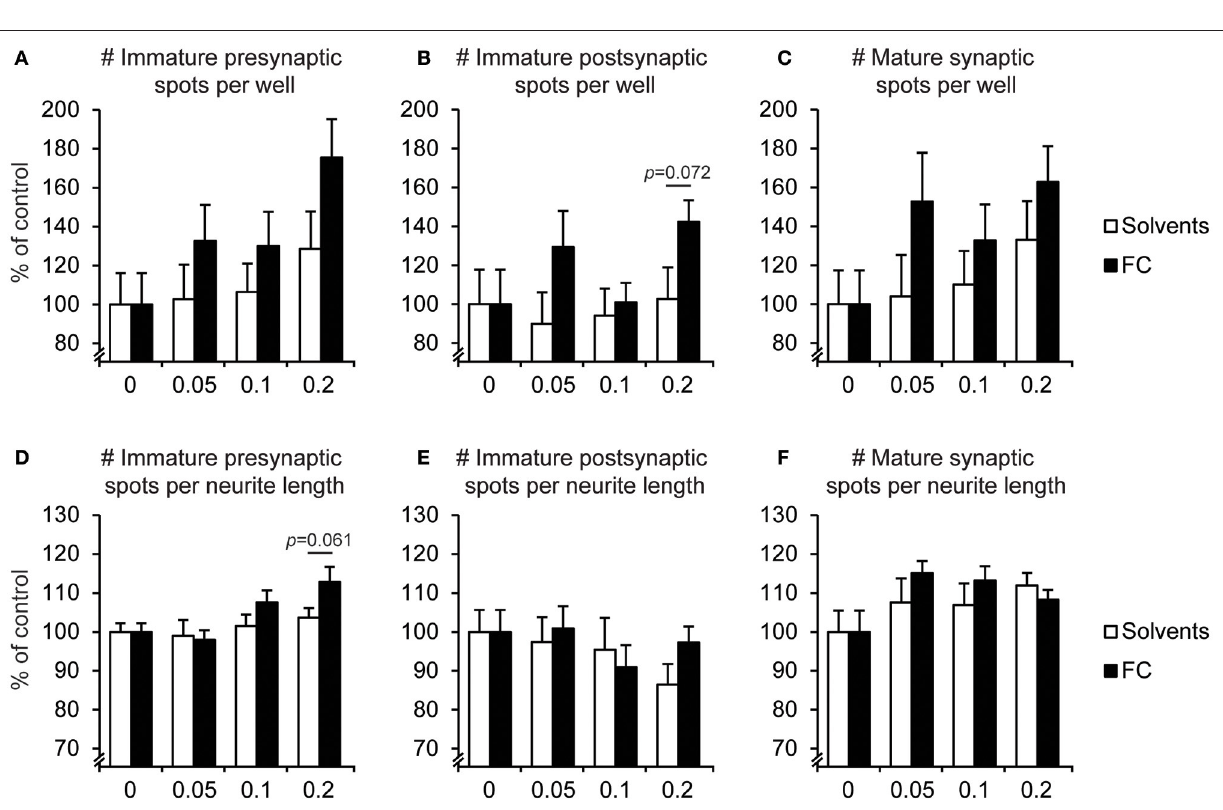
FIGURE 6 | Effect of FC on synaptic spots in primary neuron-astrocyte co-cultures . Analysis of number of (A,D) immature presynaptic spots, (B,E) immature postsynaptic spots, (C,F) mature synaptic spots, per well (A–C) and per neurite length (D–F) for: no supplementation (0) or supplementation of 0.05x, 0.1x, or 0.2x FC or solvents ( n = 6-11 wells per condition). Data were normalized to non-supplemented condition (0). Error bars represent standard error of the mean